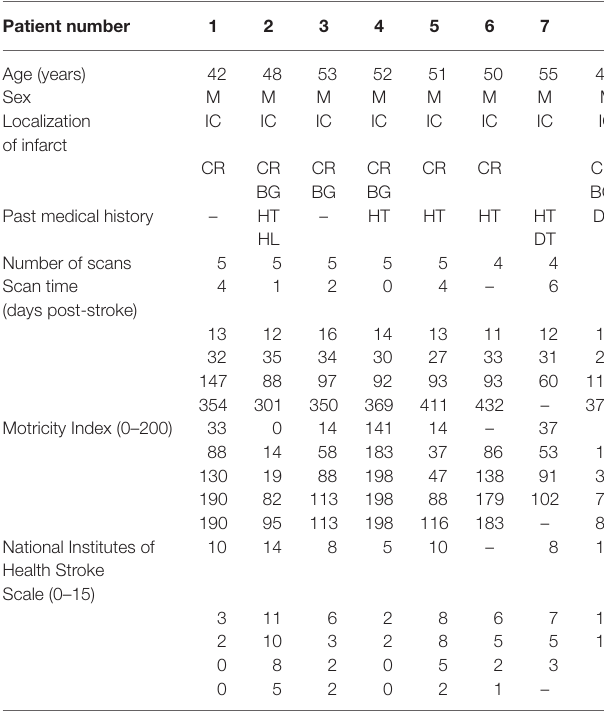
TABLE 1 | Demographic and clinical data for stroke patients